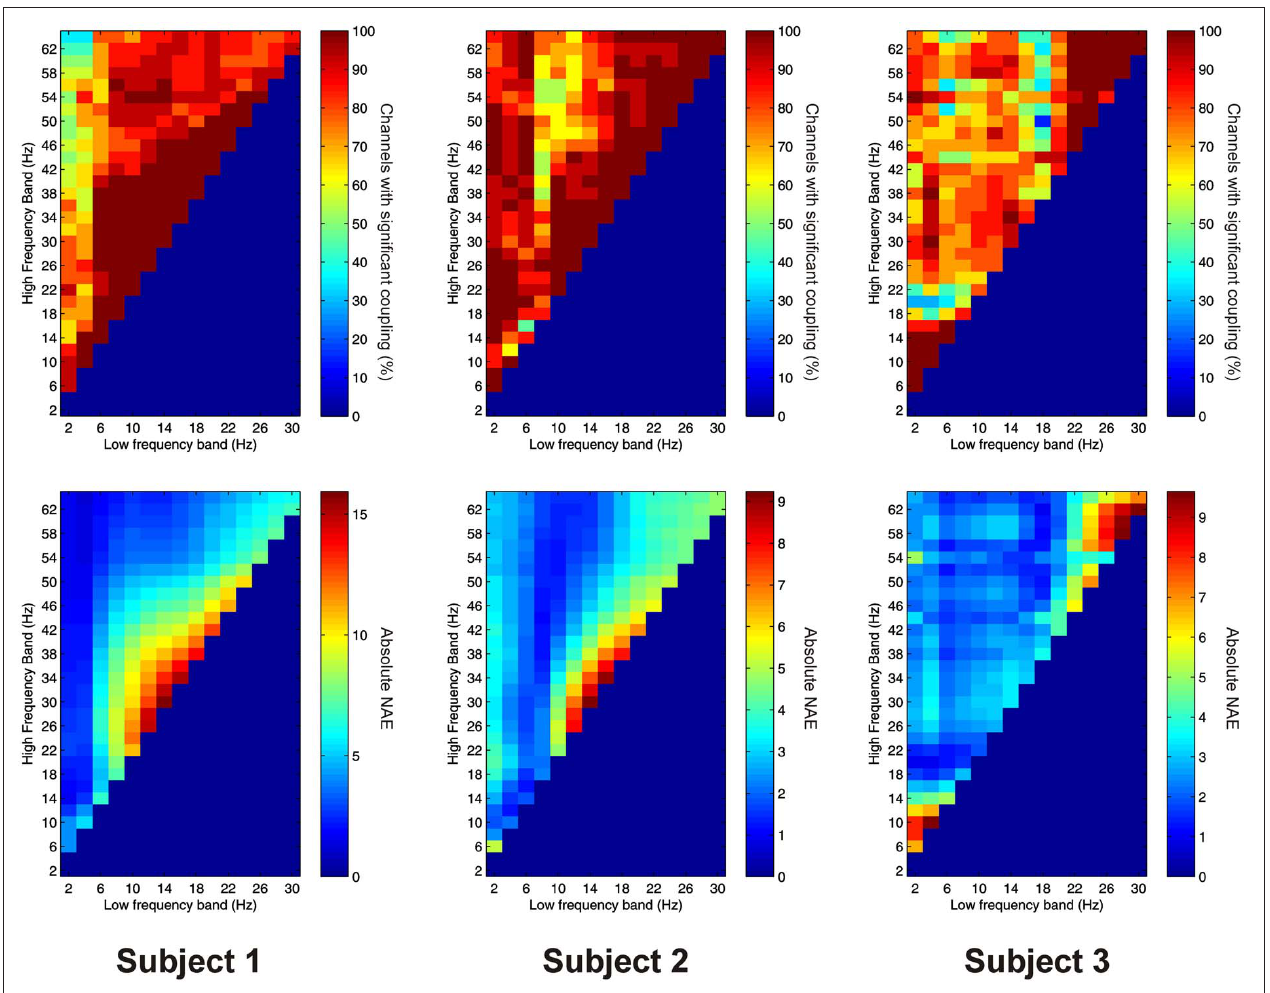
FIGURE 5 | Top row: Proportion of channels showing significant local AAC in the PFC (Subject 1 left, Subject 2 middle, Subject 3 right). Bottom row : Mean strength of AAC (assessed by the absolute value of the normalized amplitude envelope correlation) in the PFC (Subject 1 left, Subject 2 middle, Subject 3 right).